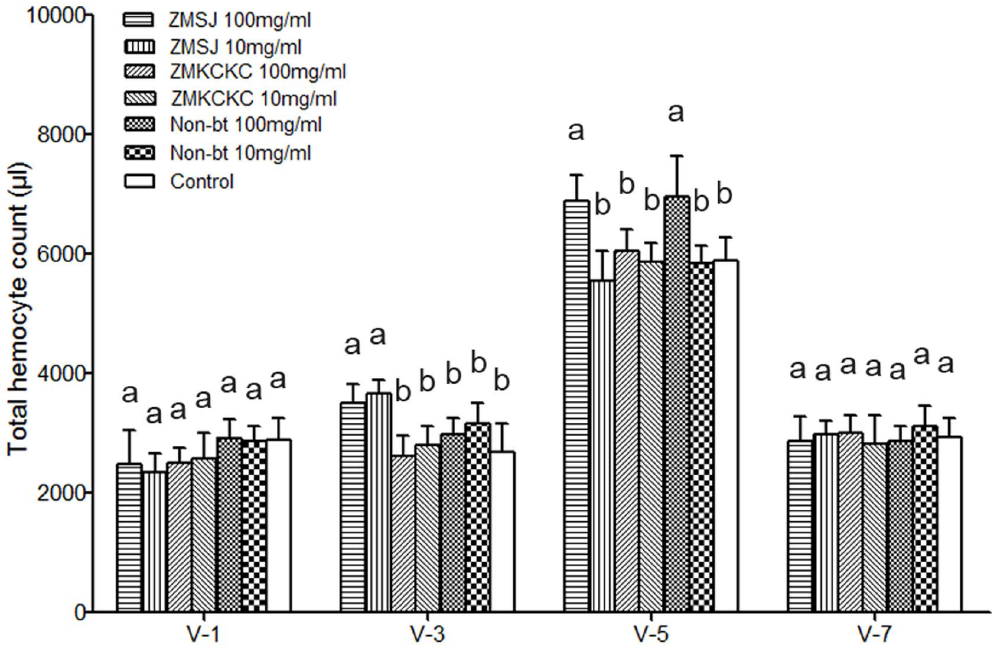
Figure 5. Mean total hemocyte count of silkworm treated with different doses of Bt pollen or non-Bt pollen. V-1, 3, 5, 7 represent the 1 st , 3 rd , 5 th and 7 th day of 5 th instar larvae. Bars represent standard error. Values with the different letter are significantly different at the P , 0.05 level (ANOVA followed by Tukey’s post-hoc test).